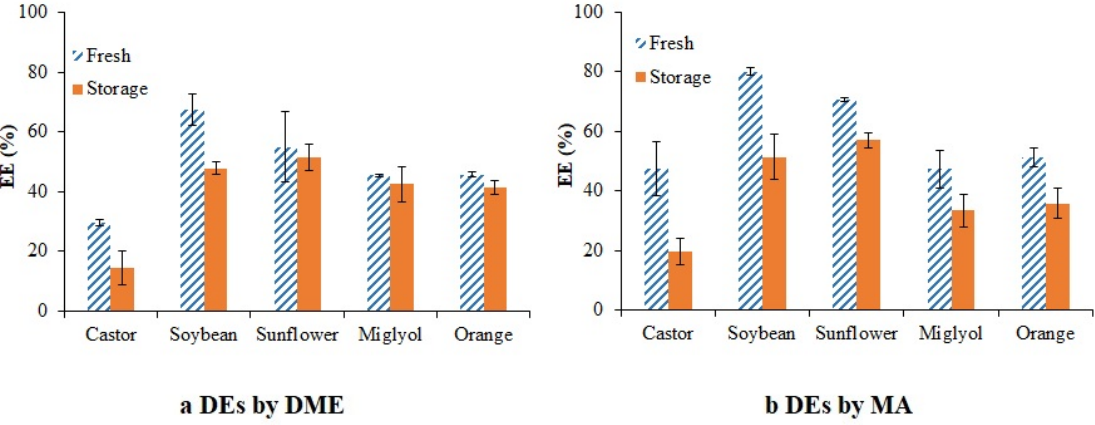
Figure 7. Encapsulation efficiency of PPE in DEs, fresh and after 20 days of storage. ( a ) Prepared by DME; ( b ) Prepared by MA.